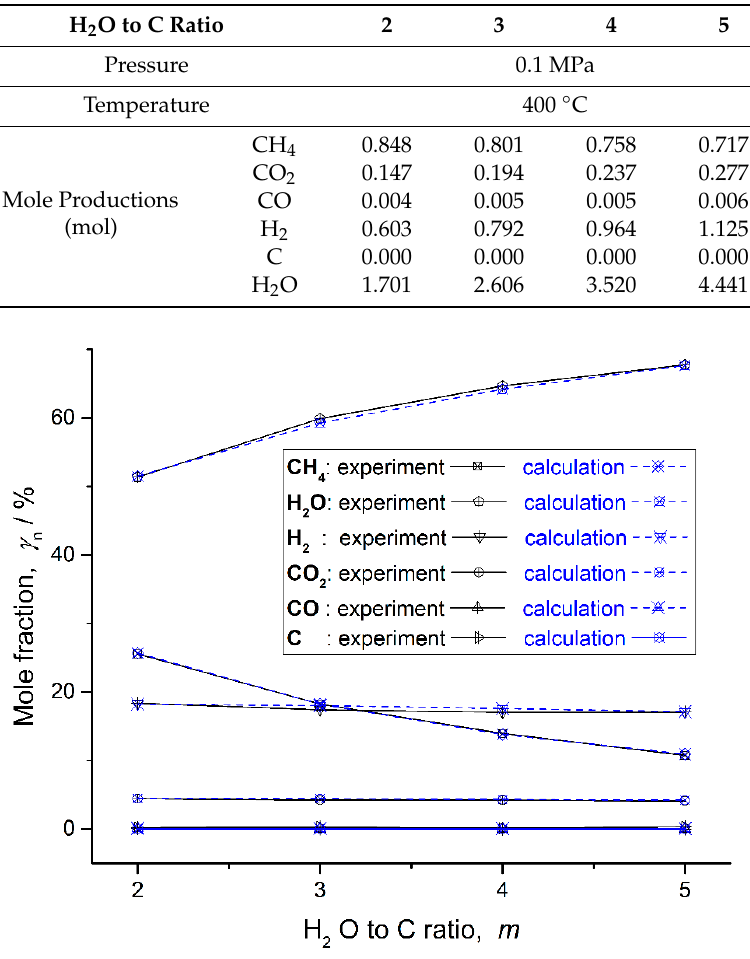
Table 2. Calculation results of the methane-steam reforming (mol).